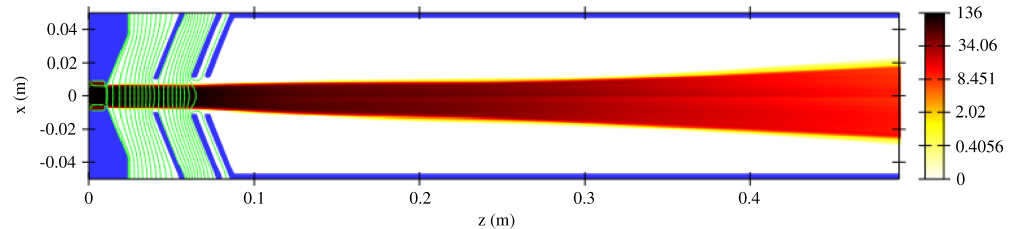
FIG. 3. Simulated particle trajectory density for the multispecies ion